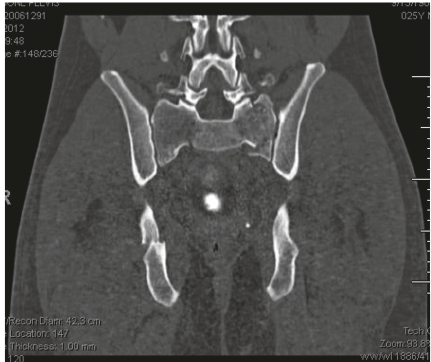
Figure3:PreoperativecoronalCTscanofapatientwithspinopelvic